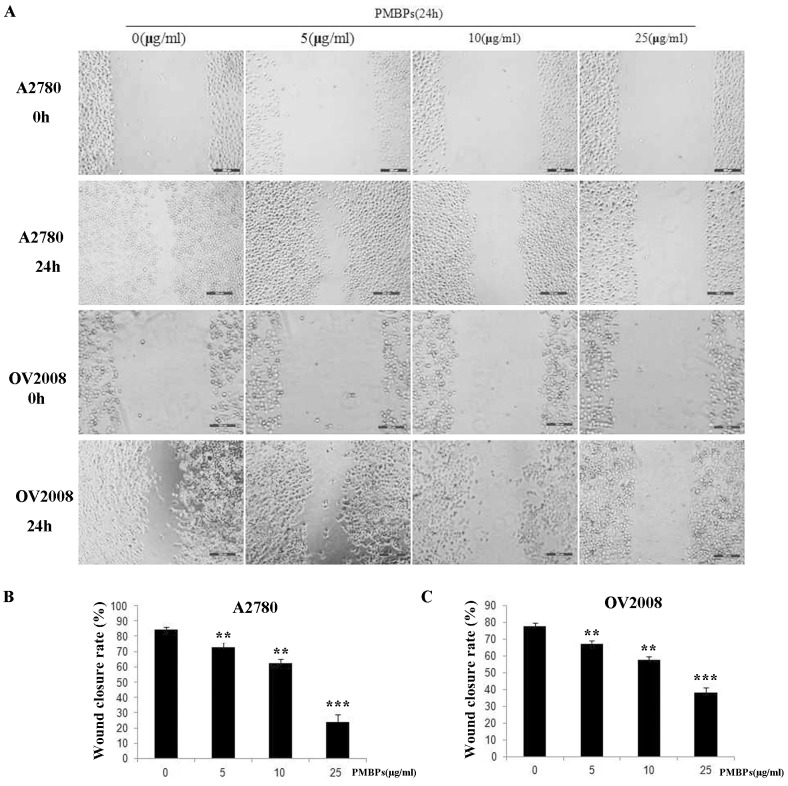
The effects of PMBPs on the migration of ovarian cancer cells by wound healing assay.Monolayers of A2780 and OV2008 cells were scratched with a pipette tip and treated with PMBPs (0, 5, 10, 25μg/ml) for 24 h. (A) Representative photos of migrating cells under microscope at 100× magnification field, before and after injury. (B,C) The migration of A2780 and OV2008 cells was quantified by measuring wound closure areas before and after injury. The experiments were repeated three times. **P<0.01 and ***P<0.001 compared to the control group.